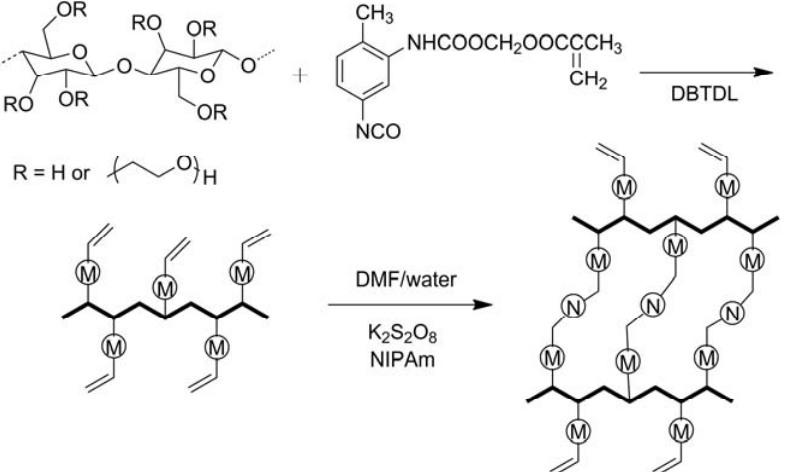
Figure 10. Synthesis route of temperature-responsive hydrogels based on HEC. Reprinted with permission from [60]. Copyright 2010 Taylor & Francis.